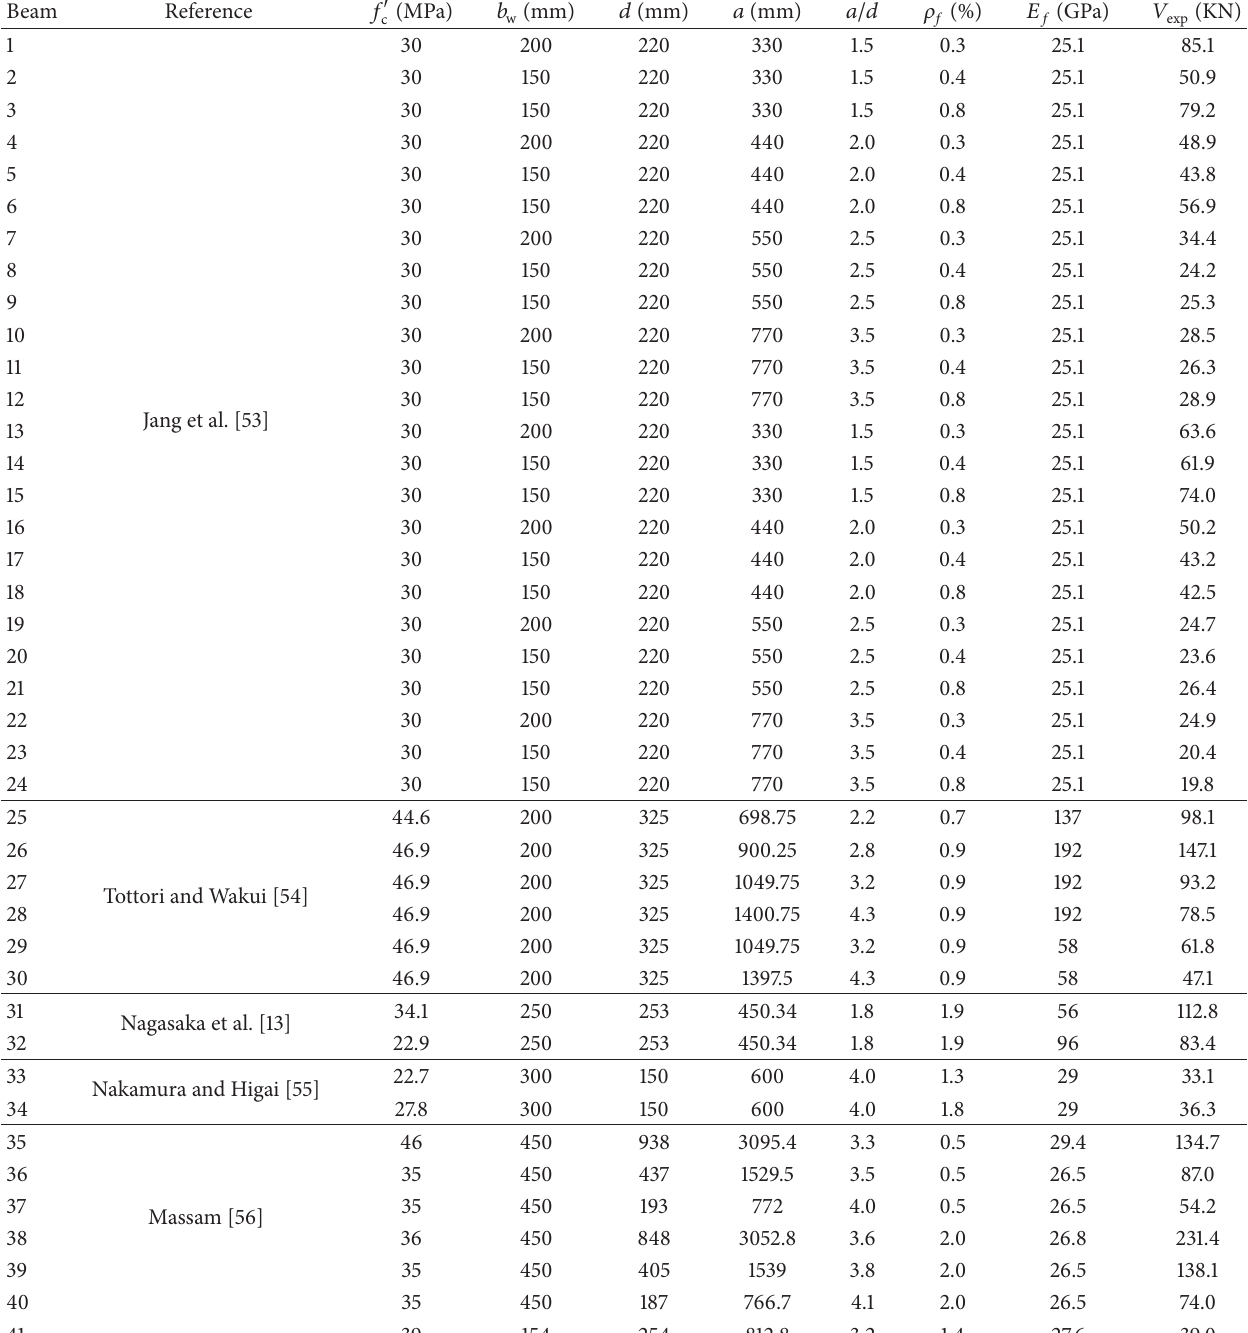
Table 7: Experimental data for